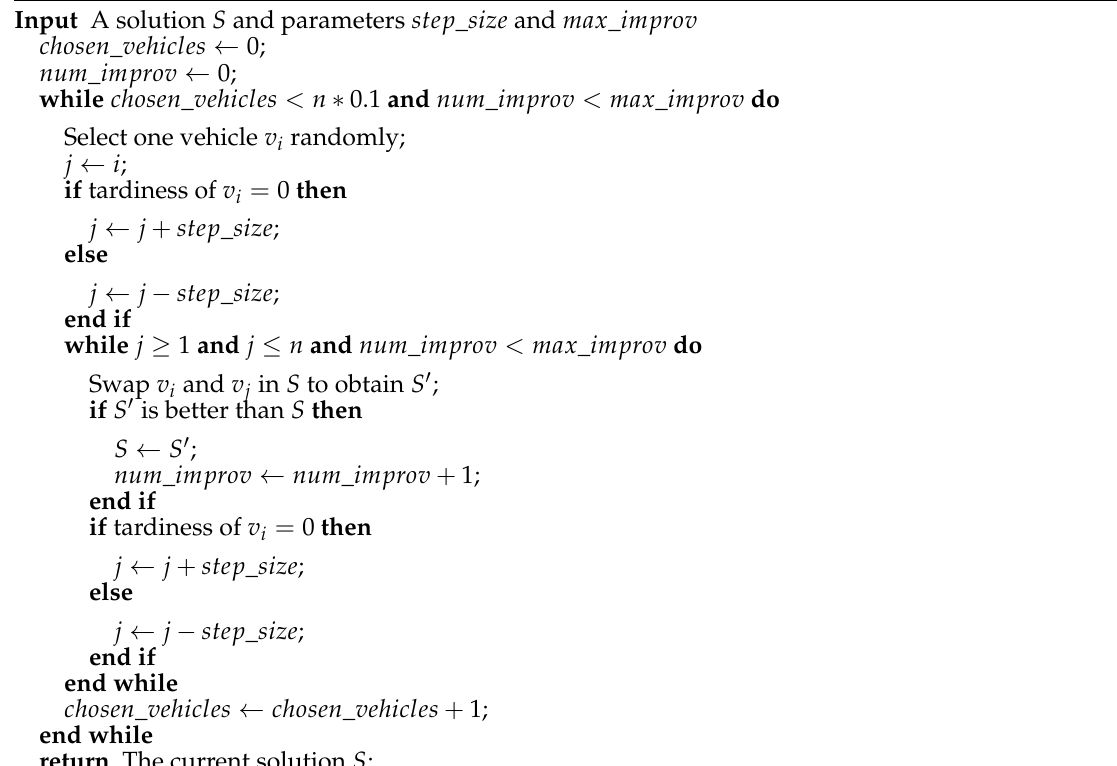
Algorithm 2 First type improvement for the onlooker bee phase o _ meth